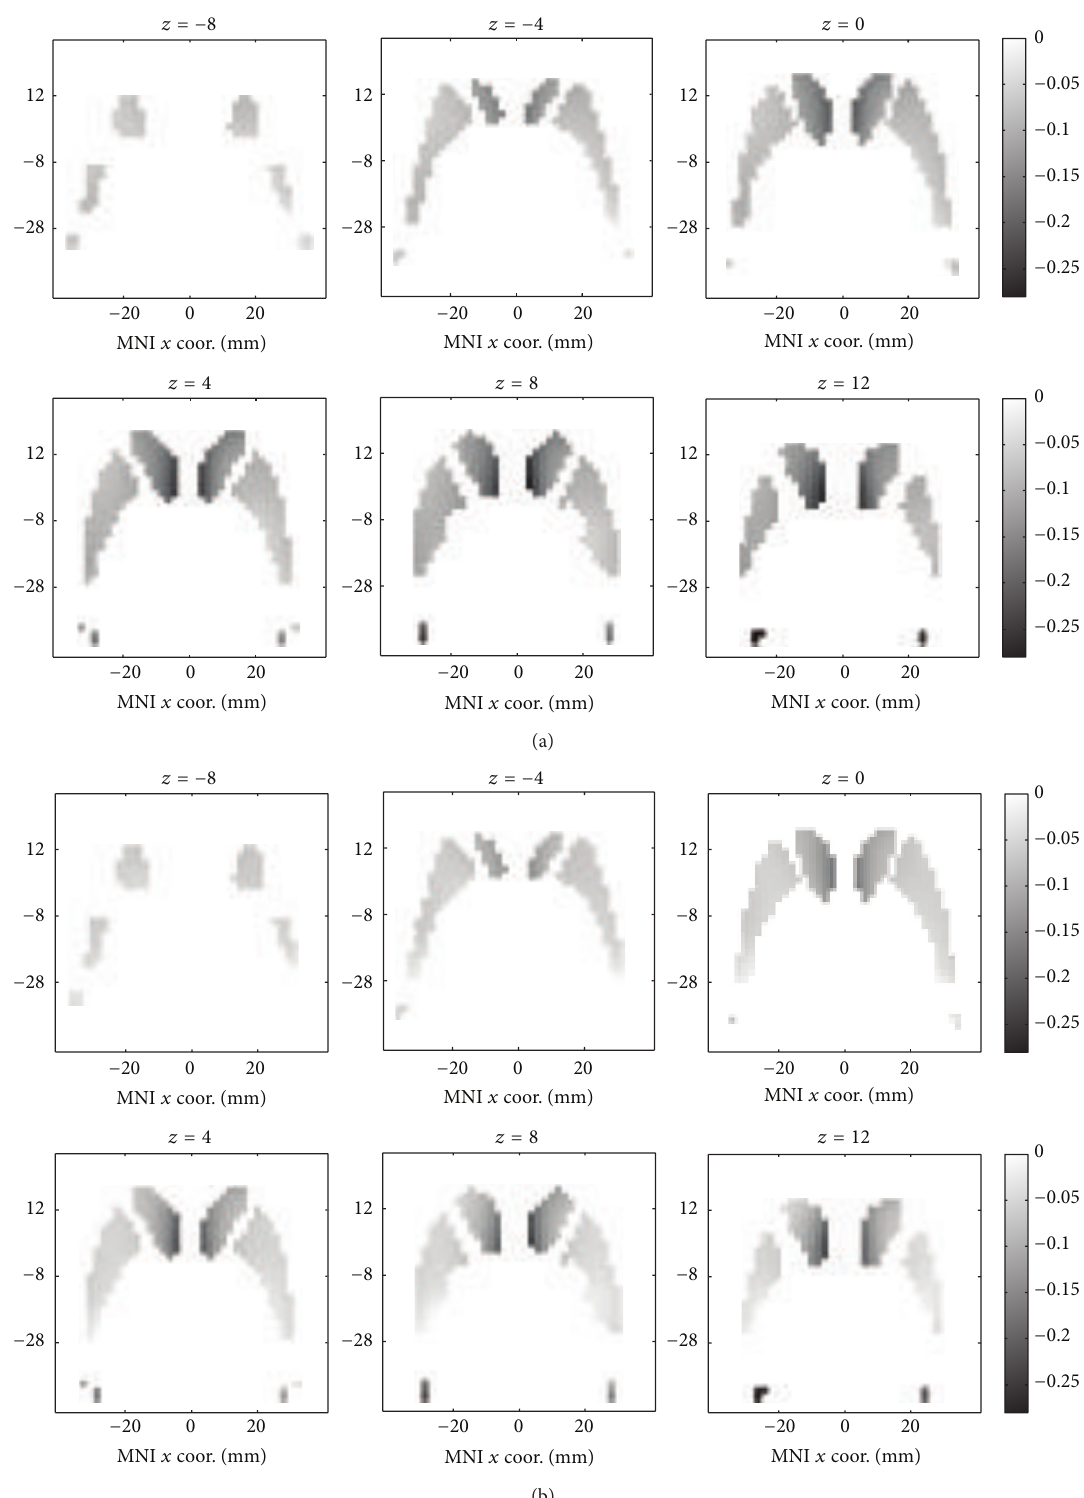
Figure 3: Decline per decade for each voxel in the MNI space. (a) MRI-normalization approach and (b) SPECT-normalization